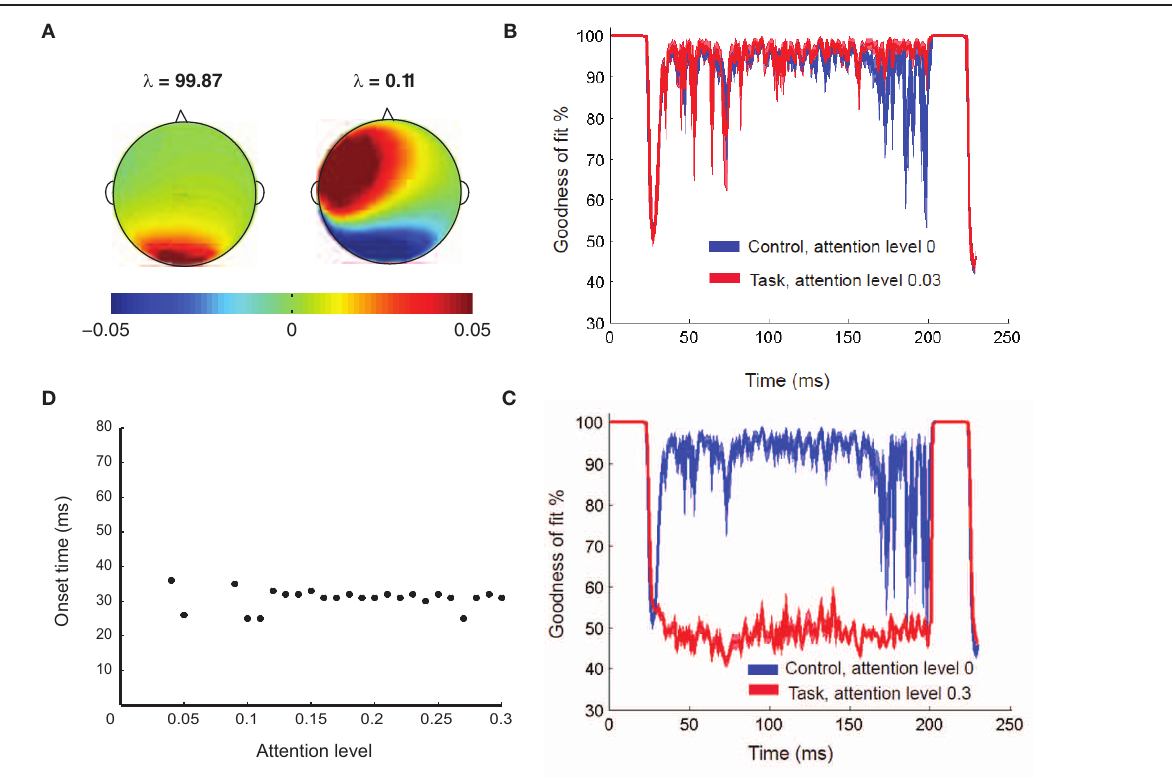
function of time when the difference in attention levels is high. The error bars at 95% significance level are also plotted as a function of time (patches). The regime of difference in Gof distributions reflect the time scale of recruitment. (D) Sensitivity analysis for onset time detection: Onset time plotted as function of different attention levels. For all levels of attention (except the zero attention scenario) the same prefrontal network (D1, D2) is recruited in the delay period, with varying degrees of intensity. At low attention (gain < 0 . 09), onset time of this prefrontal network recruitment occurs twice by chance. However, after a threshold level of attention (0.09), onset time is consistently detected for all higher